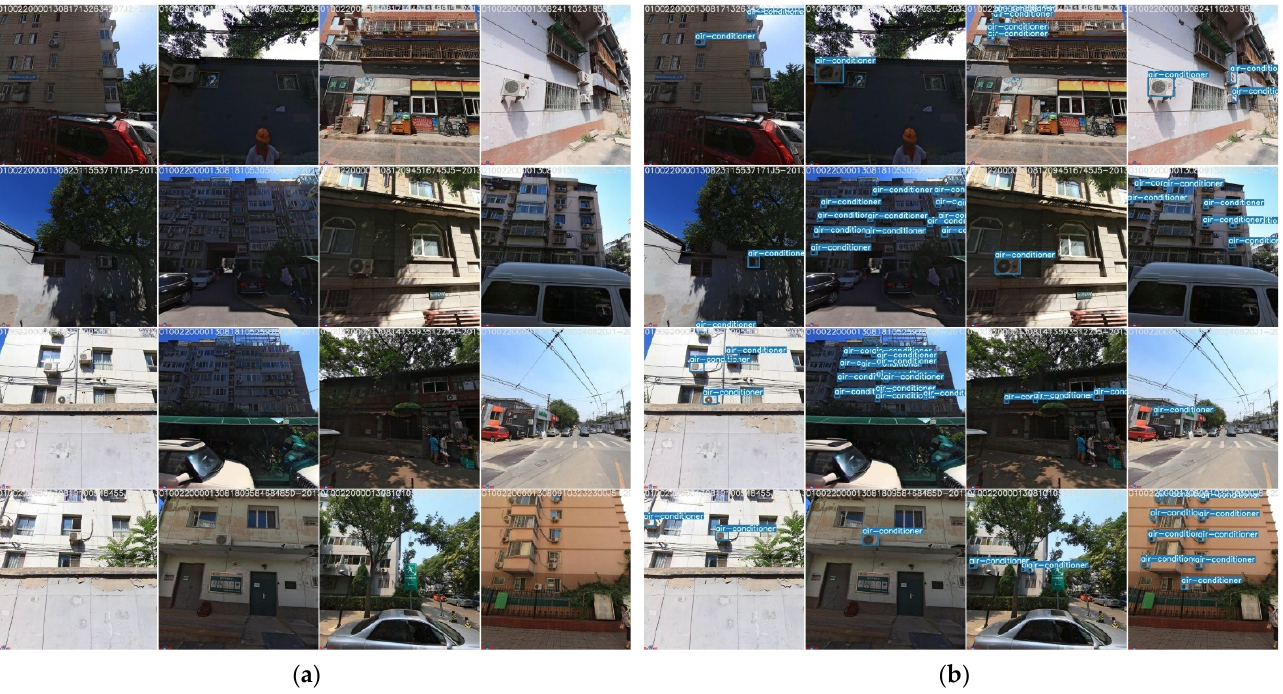
Figure 4. Example expectation result graphs in our recognition task. ( a ) indicates a combination example of several original unclassified pictures; ( b ) indicates a combination example of several classified pictures that are predicted by training models.